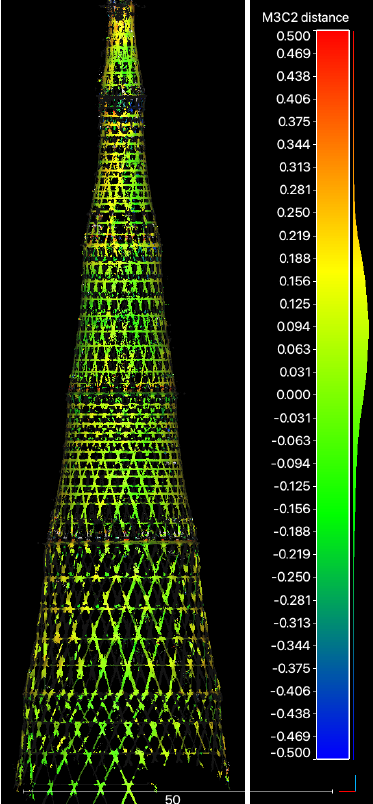
Figure 8. 3D comparison between the UAV-based point cloud and the available laser scanning